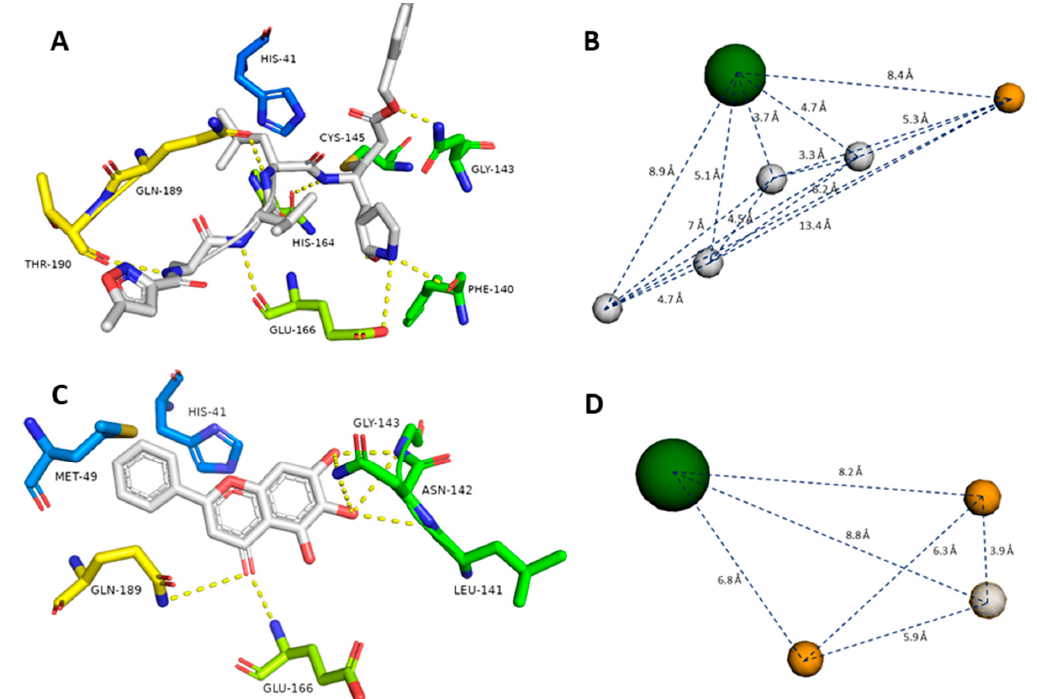
Figure 3. Generated pharmacophore models ( B and D ) according to the previously reported co-crystalized ligands ( 7 and 8 , A and C ). Gray spheres indicate hydrogen bond donors, orange spheres indicate hydrogen bond acceptors, and green spheres indicate hydrophobic centers. Green amino acid residues represent the S1 pocket, blue amino acid residues represent the S2 pocket, yellow amino acid residues represent the S3 and S4 pockets in the M pro active site ( A and C ).